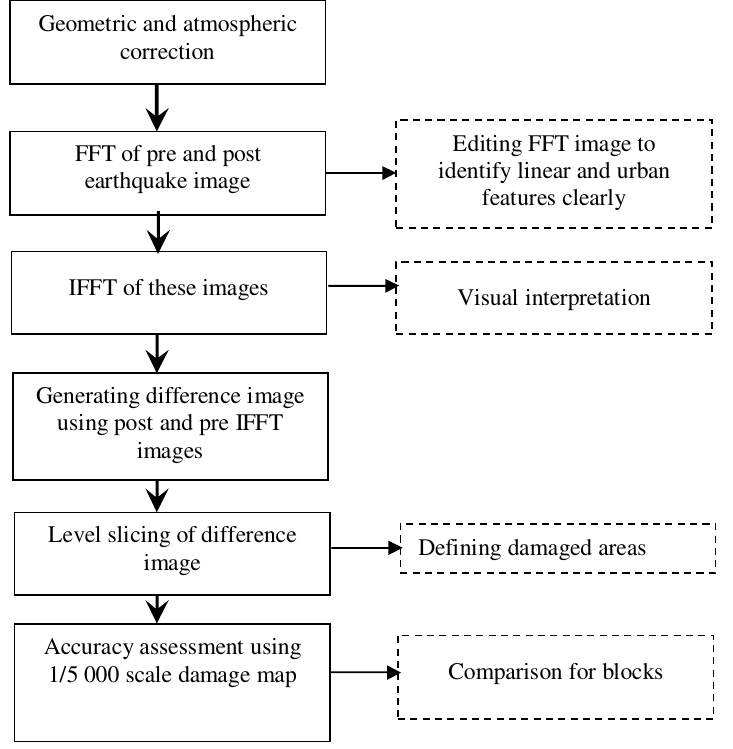
Figure 3 . Procedures conducted in the methodology.